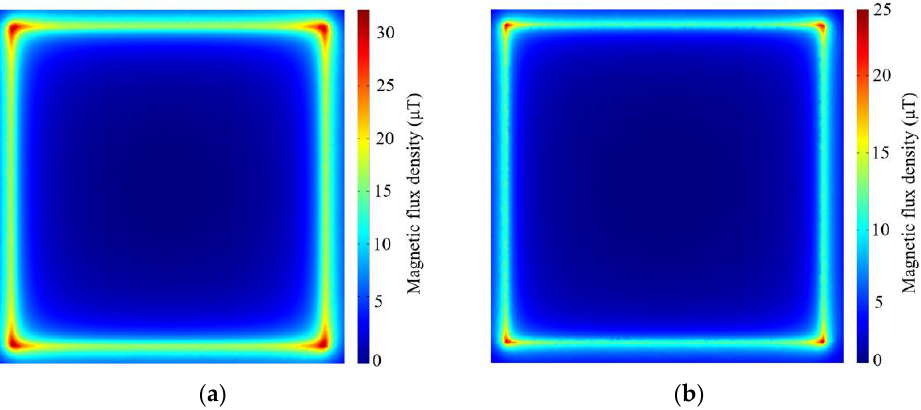
Figure 5. Simulation results of magnetic field distribution in x – z plane of ferrite shield: ( a ) transmit- ting side and ( b ) receiving side.